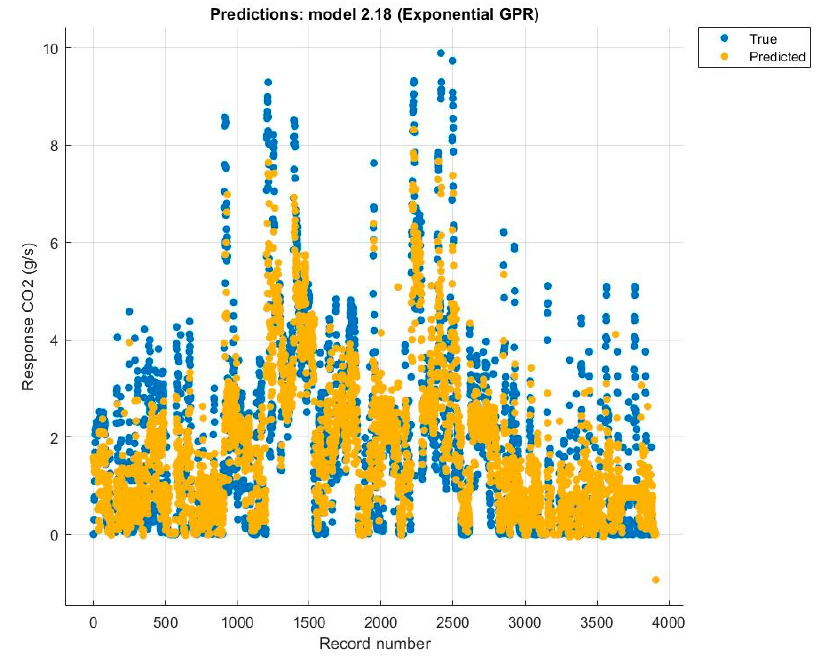
Figure 6. Prediction performance of CO 2 emission for a selected Exponential GPR computational model.